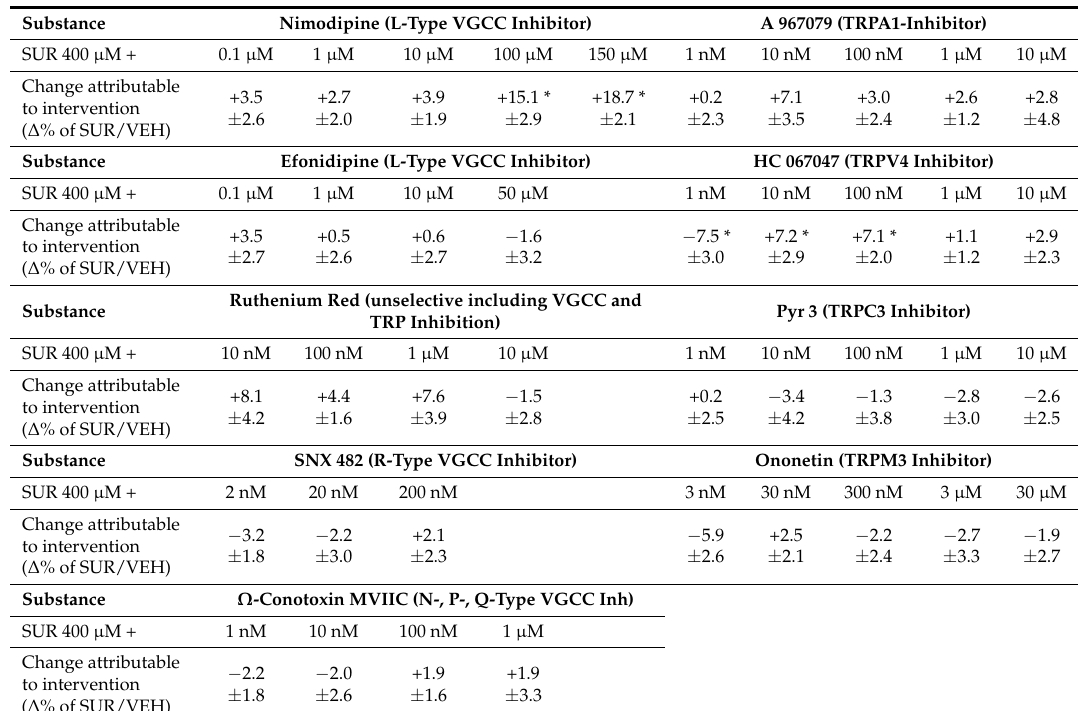
Table 1. Summary of observed cell viability of DRGN after suramin treatment in the presence of different